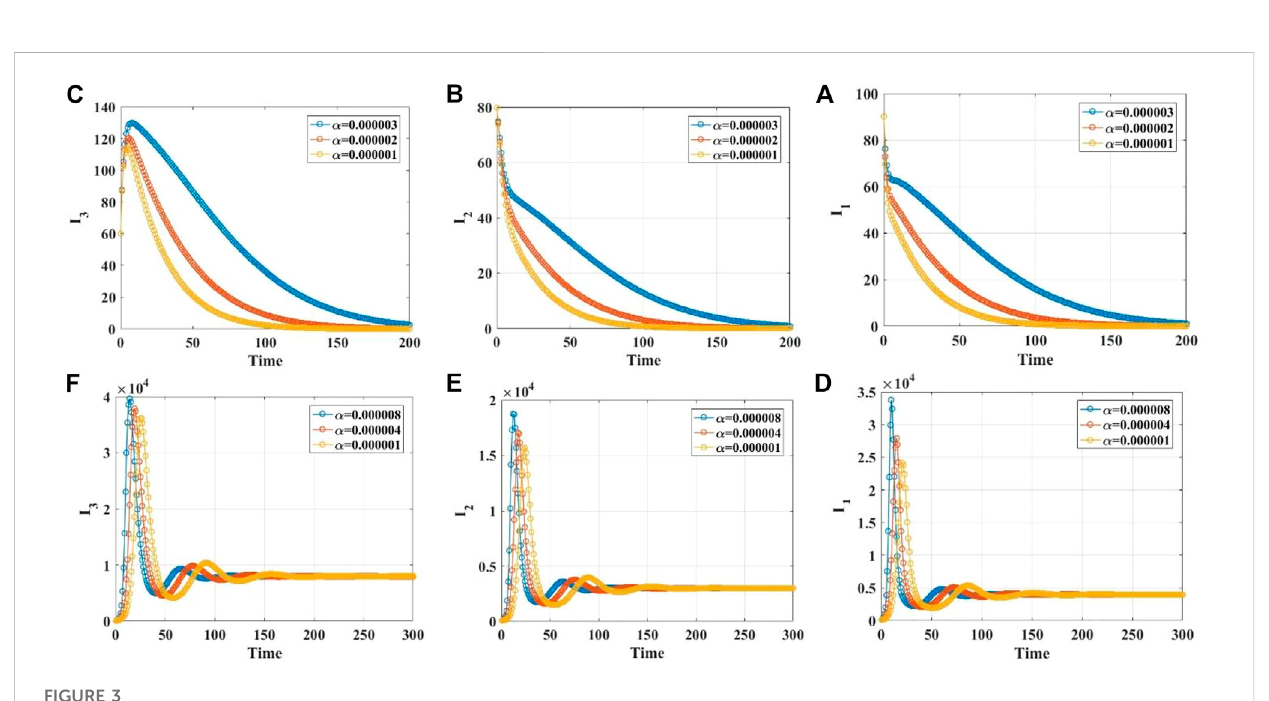
The time series diagrams for n (cid:1)